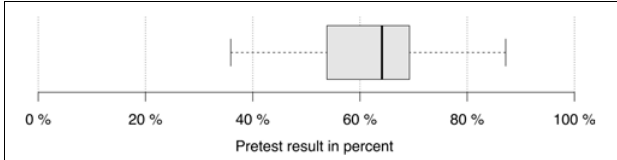
FIGURE 2 | Pre-test results of all participants.